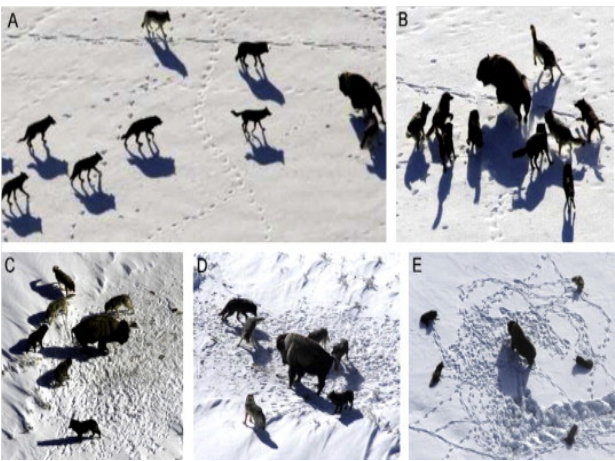
Figure 2. Prey Hunting mechanism of Grey Wolves [42]. ( A ) tracking and chasing ( B – D ) encircling and harassing and ( E ) attacking.